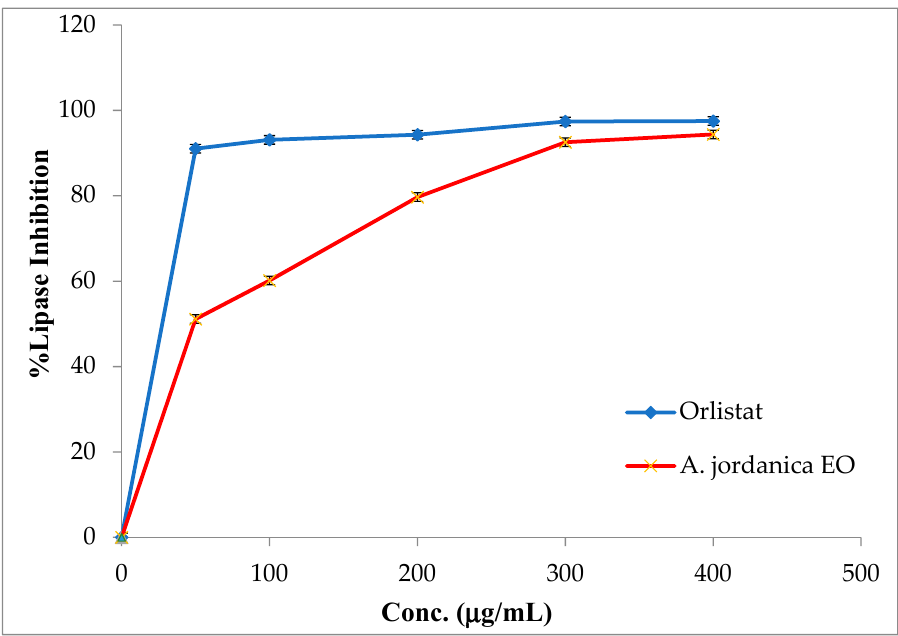
Figure 3. Porcine pancreatic lipase inhibitory activity by Artemisia jordanica essential oil and orlistat.